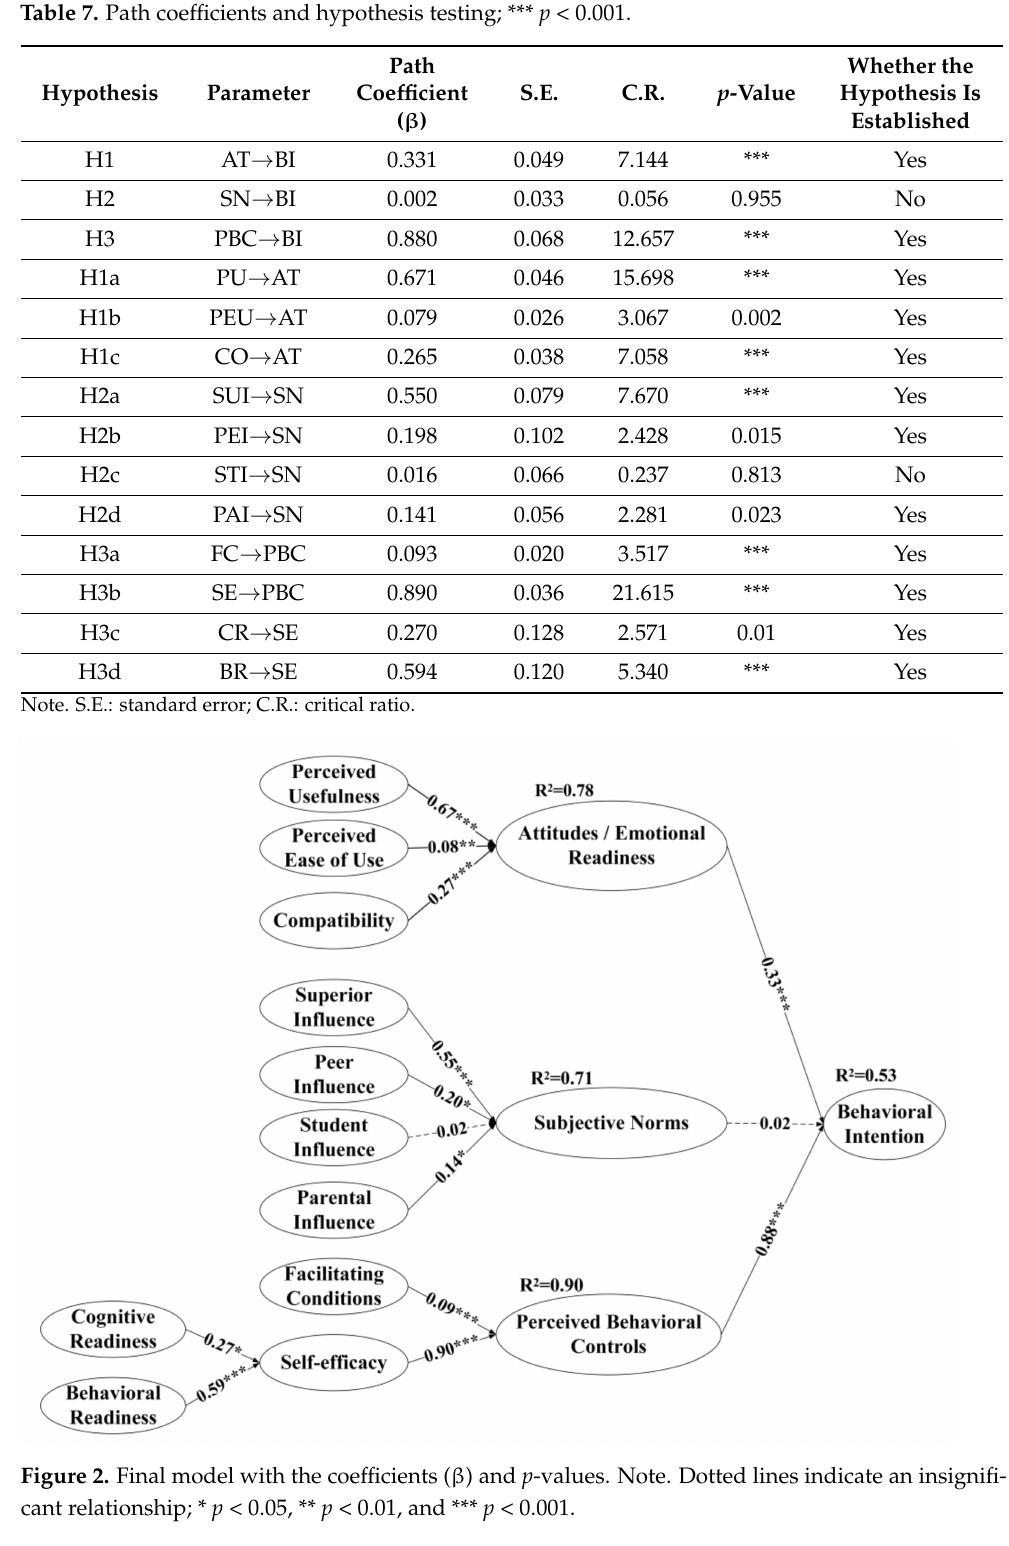
Table 7. Path coefficients and hypothesis testing; *** p < 0.001.